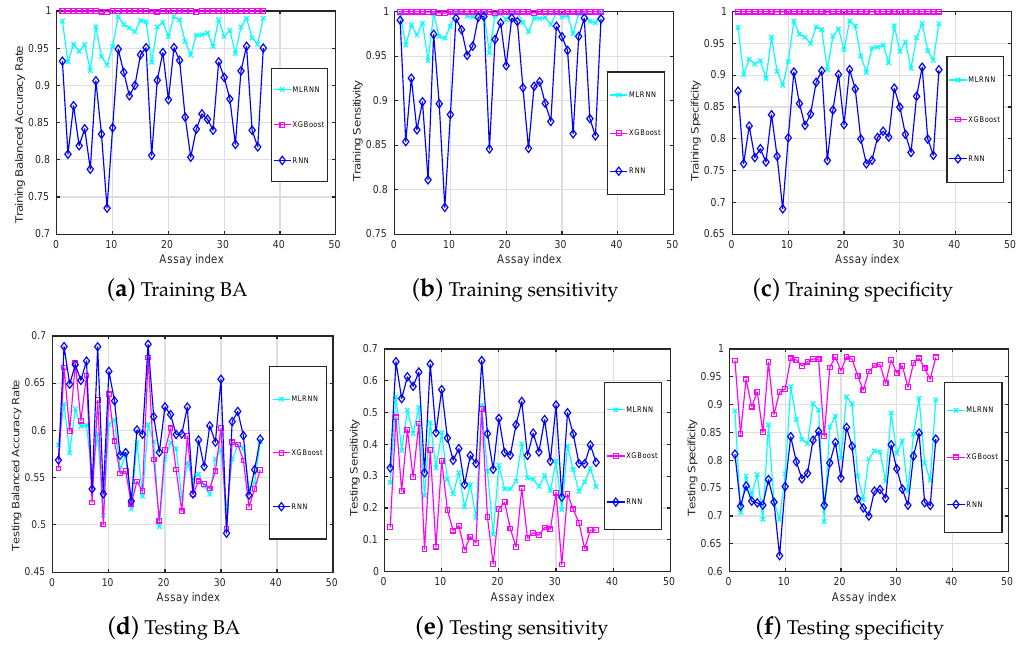
Figure 3. Training ( a – c ) and testing ( d – f ) mean-value results ( y -axis) versus different assays ( x -axis) on balanced